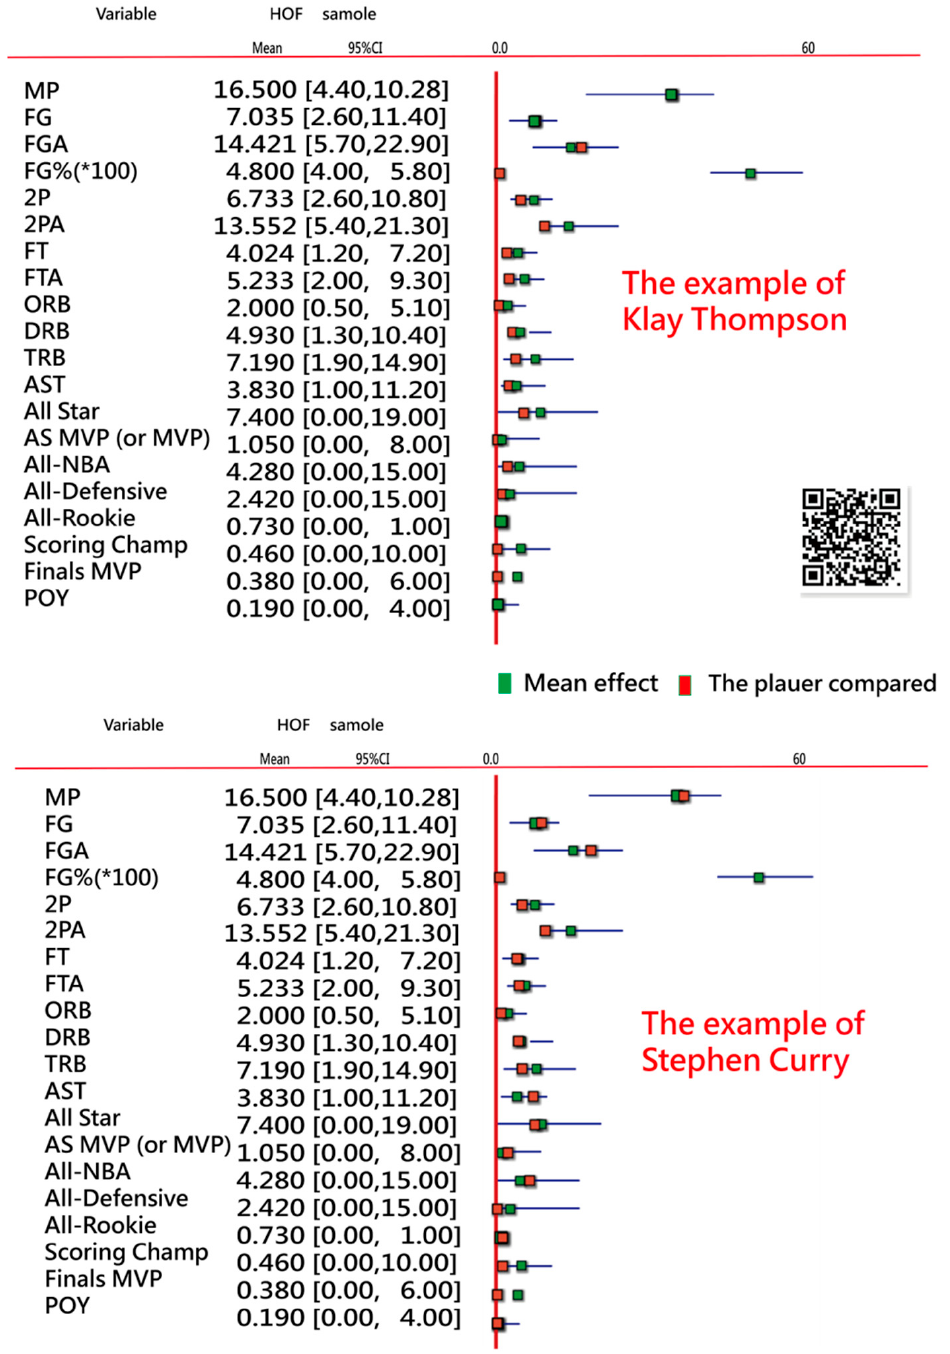
Figure 6. The interpretation of the records compared with the HOF sample for the NBA player Klay Thompson.